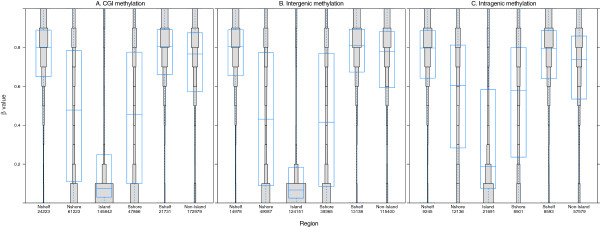
CGI methylation in different genomic regions. Distribution of DNA methylation in specific gene regions is shown. Each gene region is further divided into bins that correspond to beta values with 0.1 intervals. The area of each bin corresponds to total number of CpGs. The overall distribution and the mean of beta value of the CpGs in each gene region are shown as a box plot. (A) The distribution of DNA methylation in CGI and non-CGI regions shows that the CGI itself is largely unmethylated and that the shores and shelves are methylated. (B, C) The distribution of CGI and non-CGI DNA methylation in intergenic (B) and intragenic (C) regions. (A-C) The numbers on the x-axis correspond to total number of CpGs in each gene region; also the x-axis shows different genomic regions, and the y-axis shows the beta values.